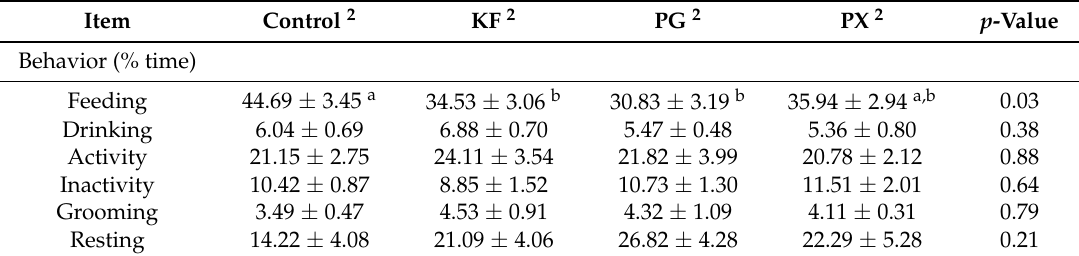
Table 2. Behavioral satiety sequence of rats given diets containing different dietary fibers on day 15 1 .